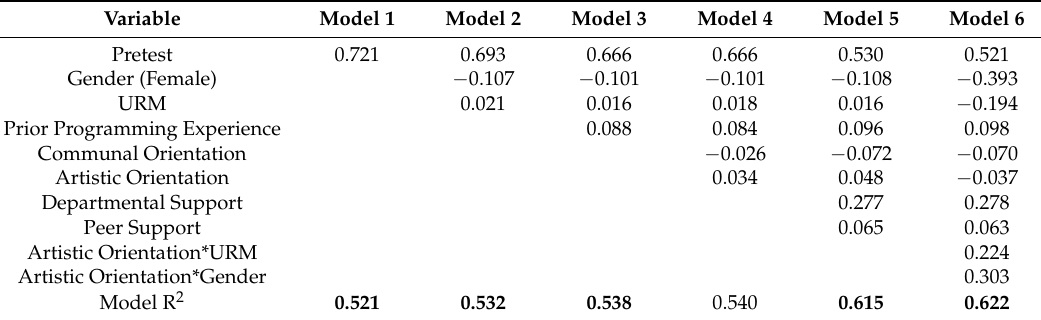
Table A3. Blocked Regression Predicting Sense of Belonging (Changes in